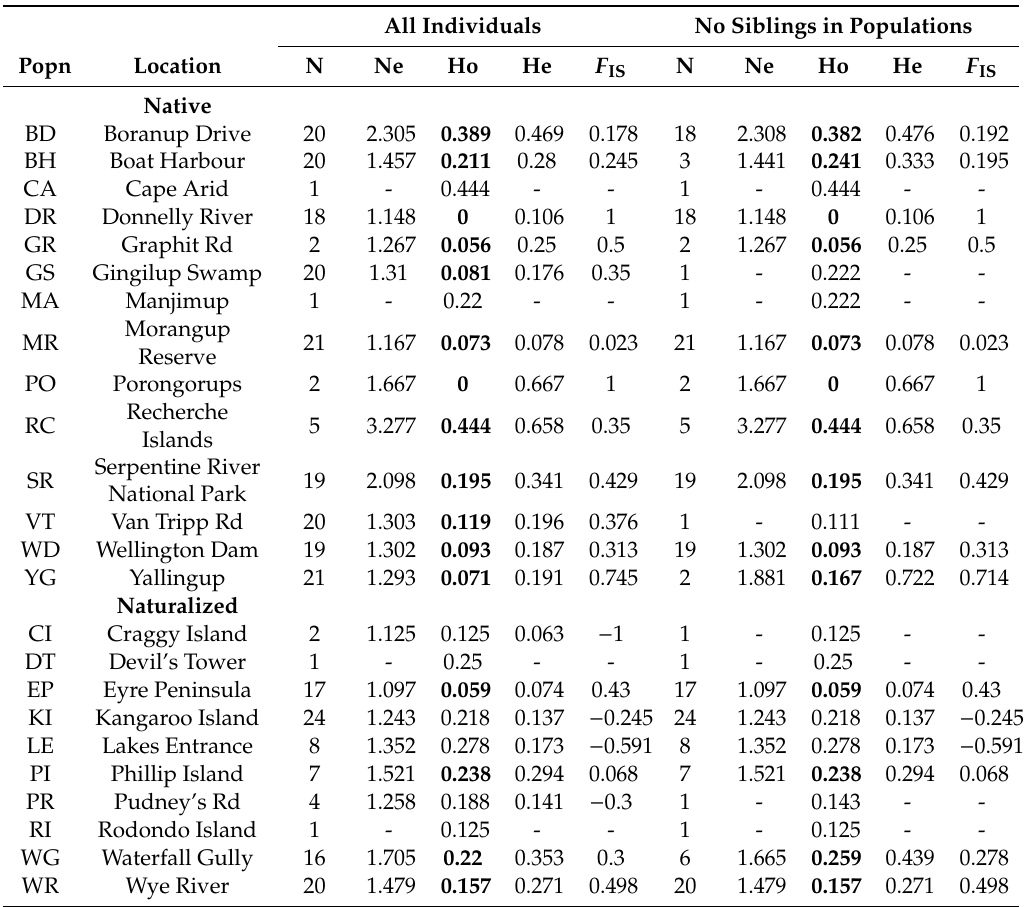
Table 1. Population information and genetic diversity for 14 native and 10 naturalized populations of Paraserianthes lophantha . N = number of individuals, Ne = number of e ff ective alleles, Ho = observed heterozygosity ( bold = Ho < He), He = expected heterozygosity, and F IS = Wright’s inbreeding coe ffi